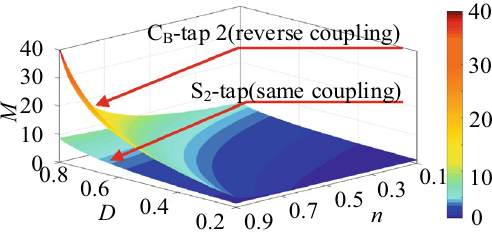
Figure 5. The voltage gain characteristic curves of the 4 circuits in step-up mode.